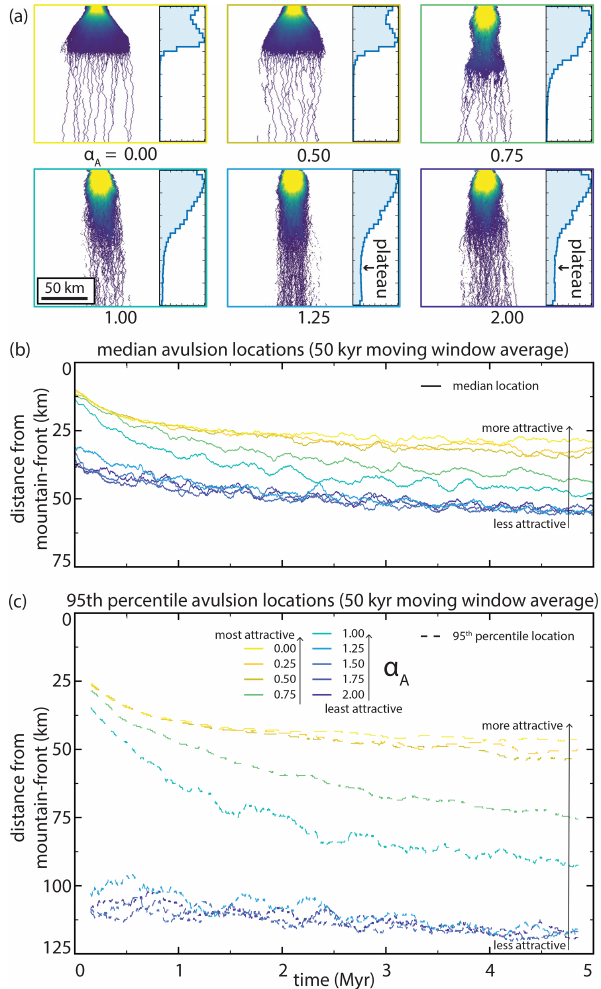
Figure 11. The effect of abandoned channel attraction on (a) plan- form appearances and normalized avulsion location histograms, and (b, c) characteristic avulsion locations through time. α A legend and x -axis scale in panel (c) applies to (b) as well. Note the difference in y -axis range between panels (b) and (c) . Between α A values of 0.50 and 1.50, increasing α A causes predictable increases in the distance between the mountain front and median and 95th percentile avul- sion locations. These changes are more pronounced for 95th per- centile locations, indicating greater skewness. Color scale for inset planform appearances is the same as in Fig.